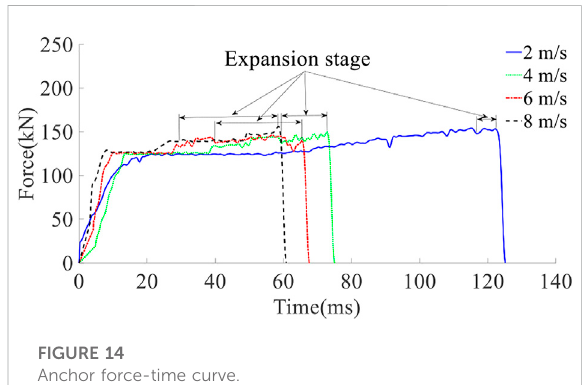
FIGURE 16 Anchor give way distance at different impact velocities.